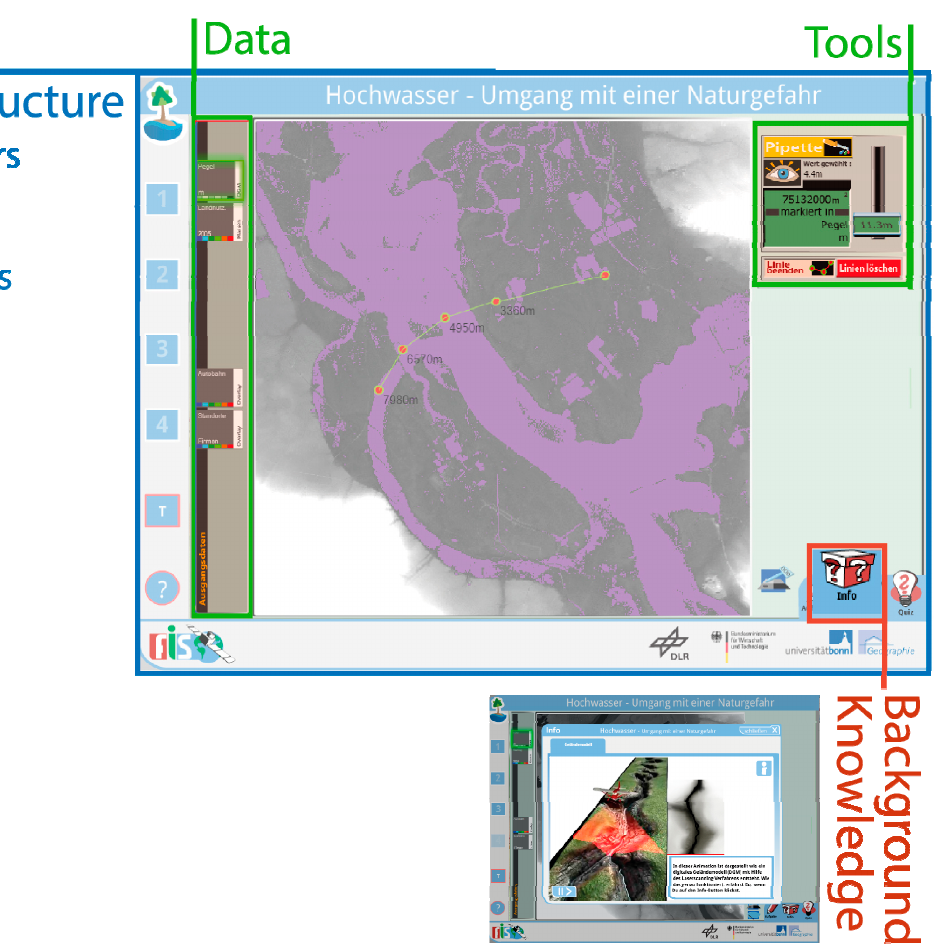
Figure 1. Annotated screenshot of the module “Floods—Dealing with a constant thread”. All data and the necessary tools are integrated in the learning environment. Background knowledge is made available through an info box. The infrastructure is a combination of methods by which to structure the whole learning module (Source: see Appendix